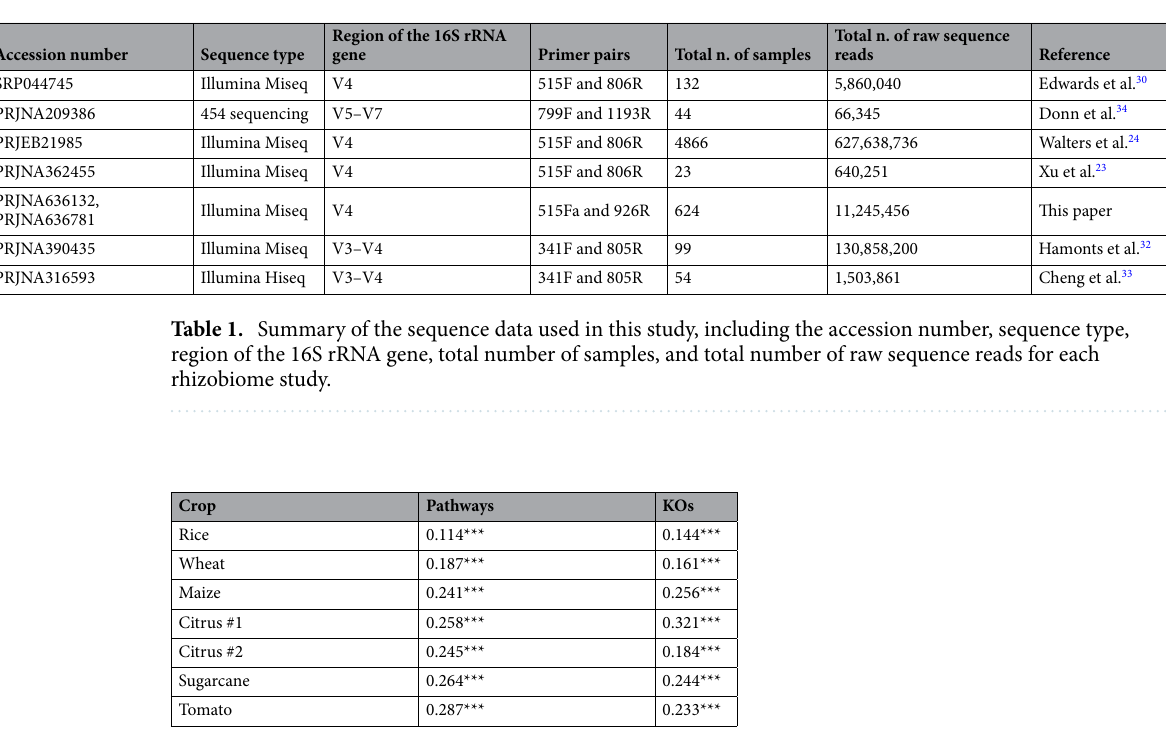
Table 2. Variations in the functional composition of the rhizobiome between the taxonomic and functional core rhizobiomes at the pathway and KO levels as explained by weighted Bray–Curtis dissimilarity using the Adonis test. R 2 values are shown; 999 permutations. * p < 0.05, ** p < 0.01, *** p <